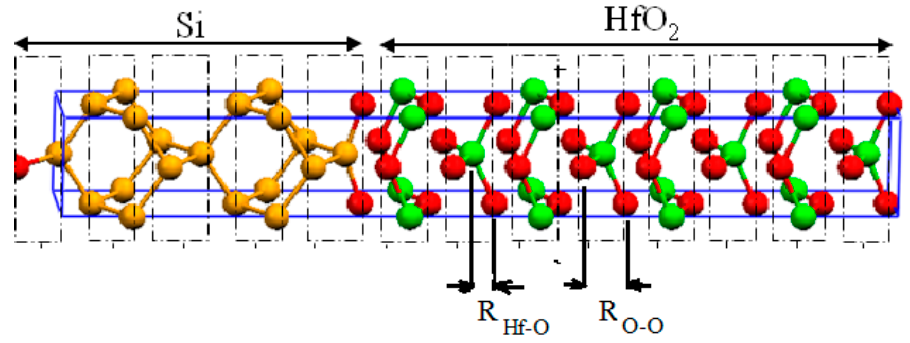
Figure 2. Model of the Si-HfO 2 structure.